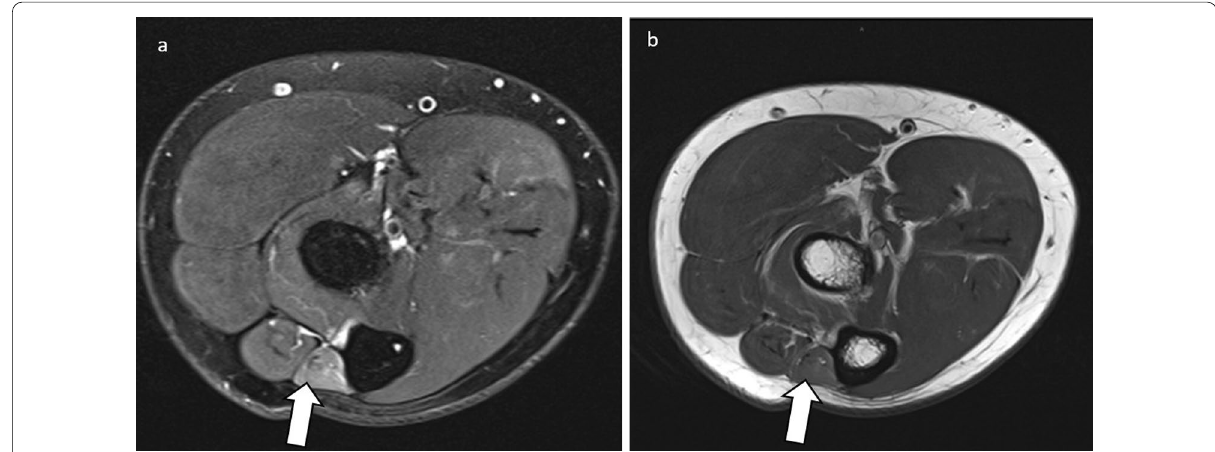
Fig. 9 PDFS ( a ) and PD sequence ( b ) of 40-year-old male with anconeus denervation oedema (white arrows) due to radial nerve neuropathy. The anconeus is supplied by the radial nerve before it bifurcates into the deep motor and superficial sensory branches, hence the cause of neuropathy